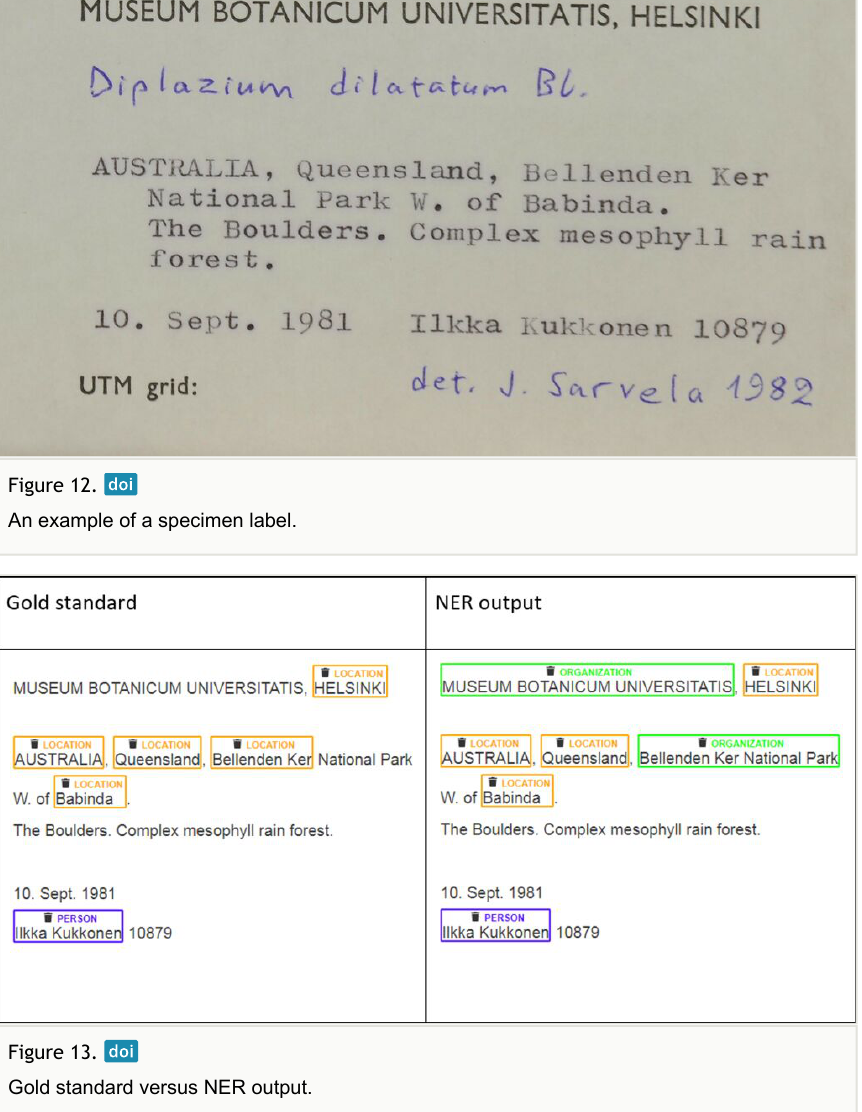
Figure 13. Gold standard versus NER